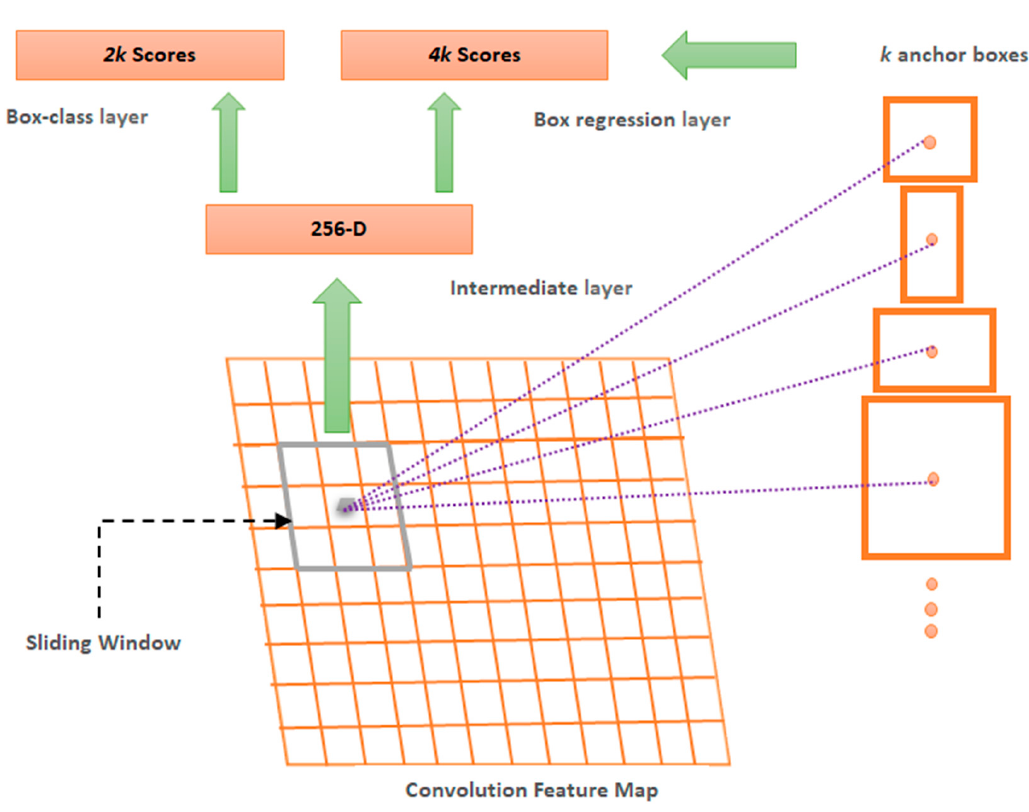
Figure 5. The architectural model of the fully convolutional region proposal network.